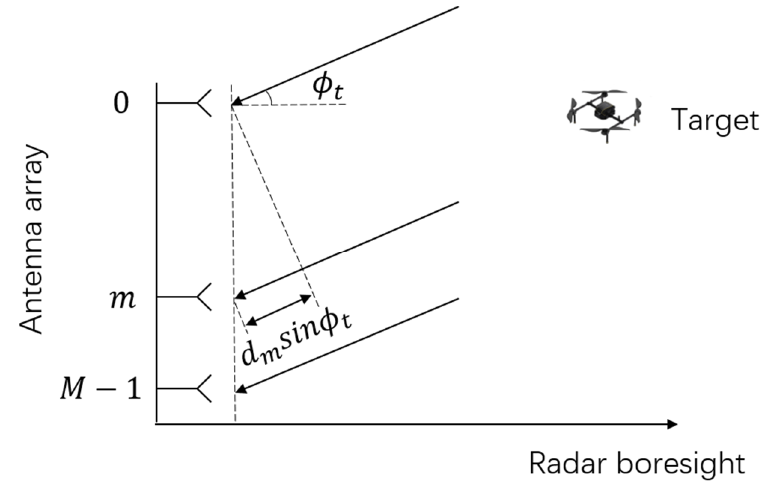
Figure 1. The geometry of signal